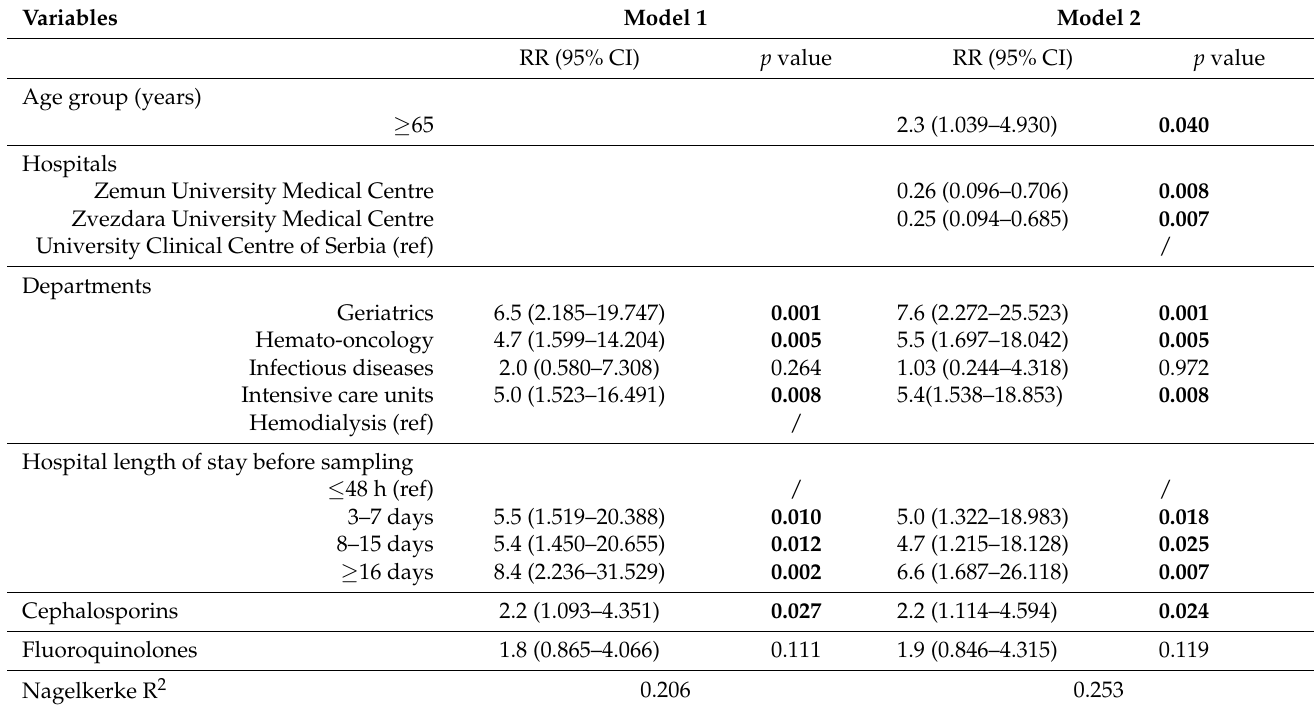
Table 3. Multivariate logistic